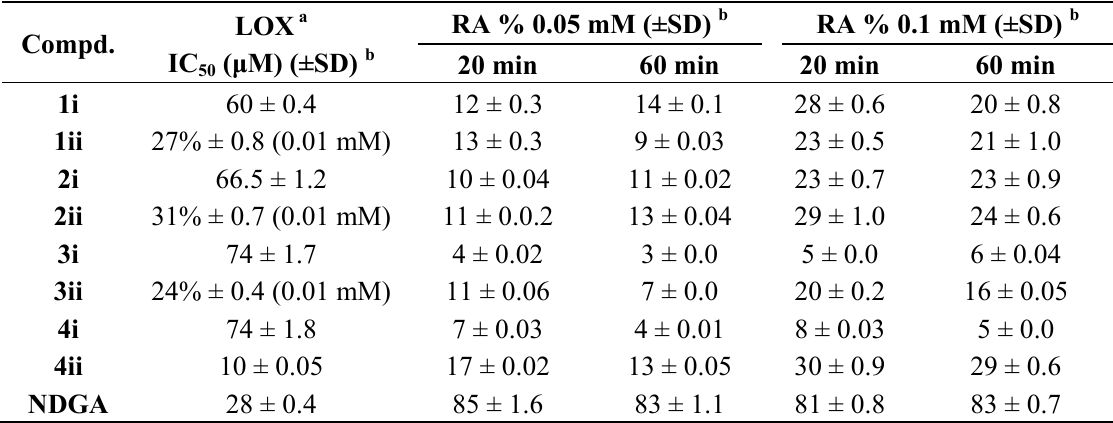
Table 2. In vitro lipoxygenase (LOX) inhibitory activity of cinnamic acid derivatives 1 – 4 . Percent interaction of the cinnamic acids 1 – 4 with the stable radical 1,1-diphenyl- picrylhydrazyl (DPPH). Compd.